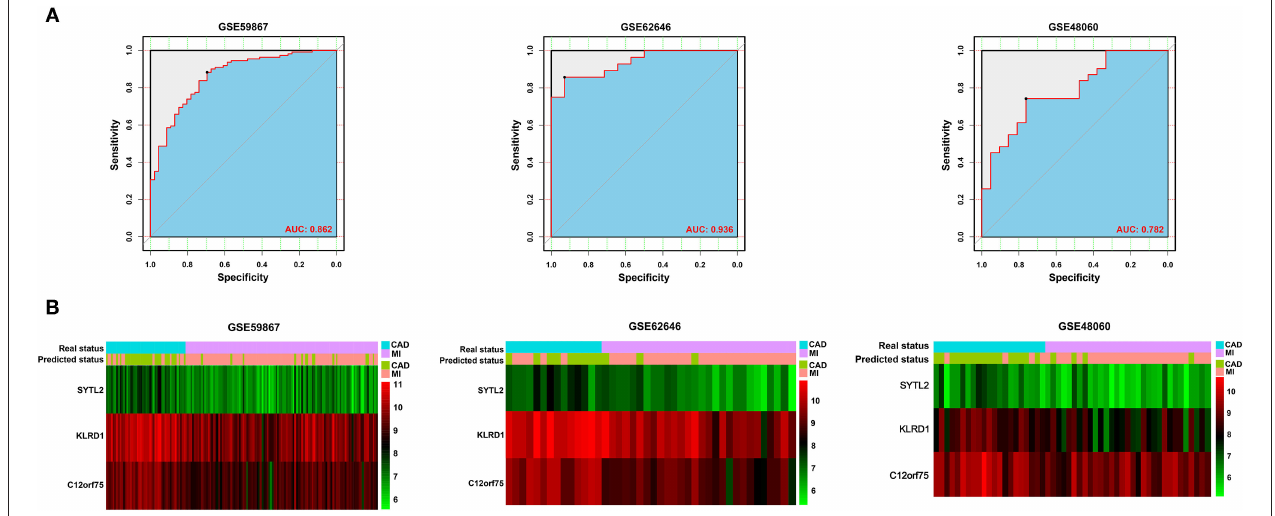
FIGURE 4 | Validation of diagnostic biomarkers for SD-related MI. (A) ROC analysis revealed good diagnostic performance of the risk score associated with MI among the three datasets. (B) Unsupervised hierarchical clustering of risk scores in the diagnostic prediction model among the three MI-related